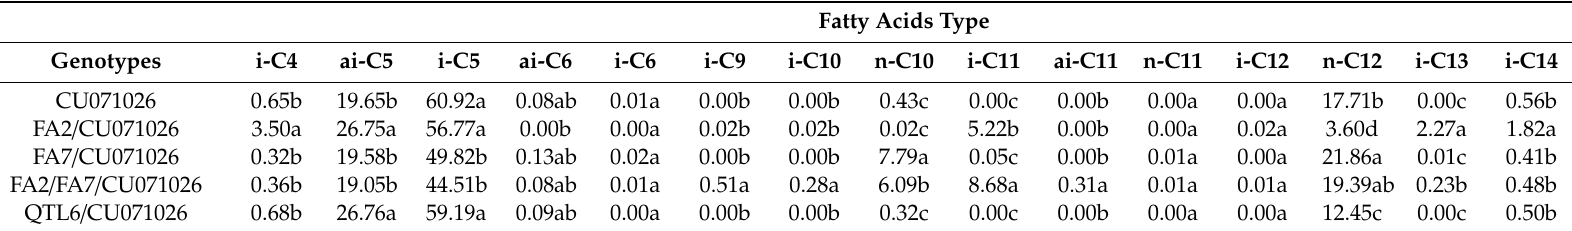
Table 1. Composition of fatty acids from five acylsugar-producing lines. Fatty Acids